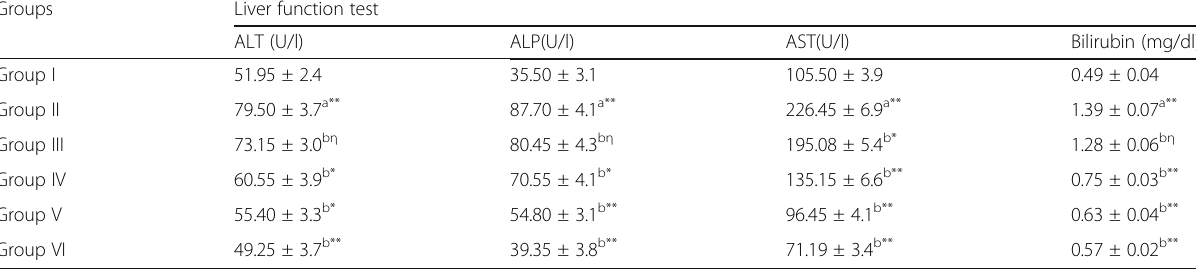
Table 4 Effect of CRME on Liver function test Groups